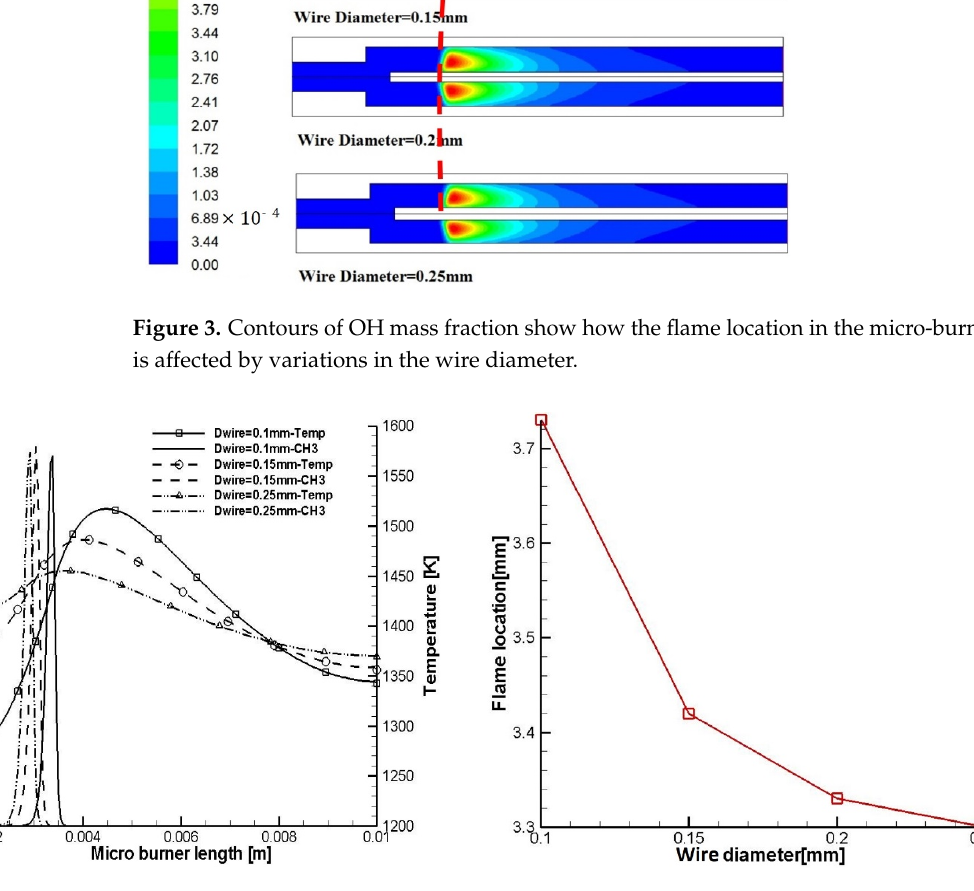
Figure 4. ( a ) The effect of wire diameter on temperature and methyl radical distribution on the outer surface of the inserted wire; ( b ) the flame location versus diameter of the inserted wire.